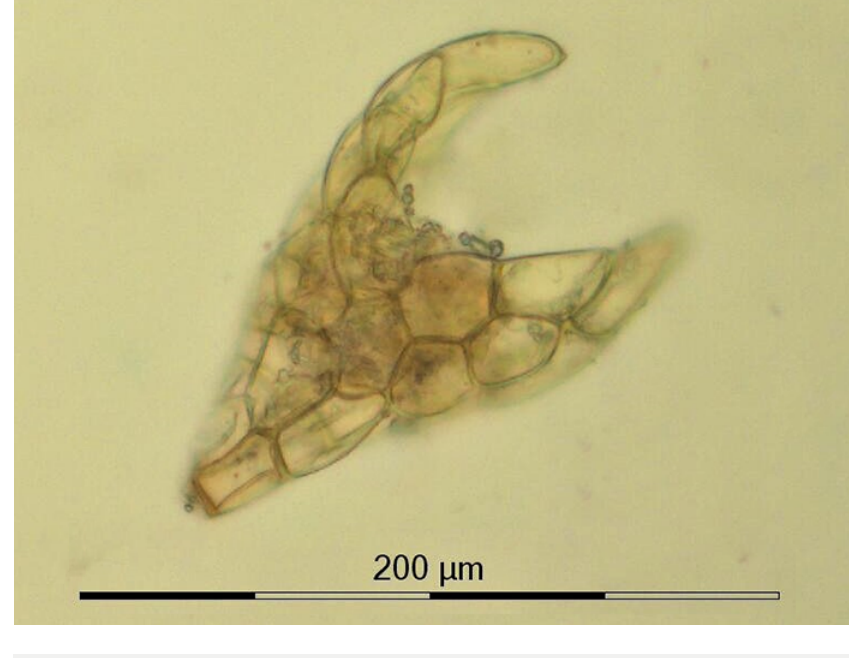
Figure 4 Gemma of Bryum gemmiferum from Wapienno (No. 226 POZG) (photo G. Vončina).